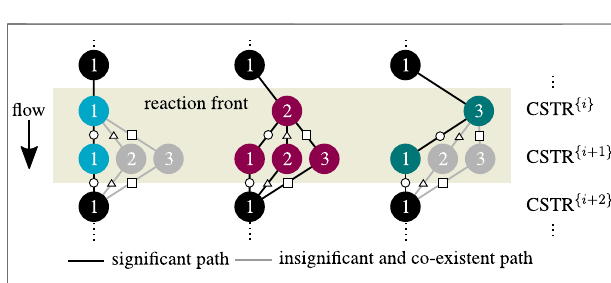
FIGURE 11 | Possible state combinations of a multi-stage CSTR cascade with two key